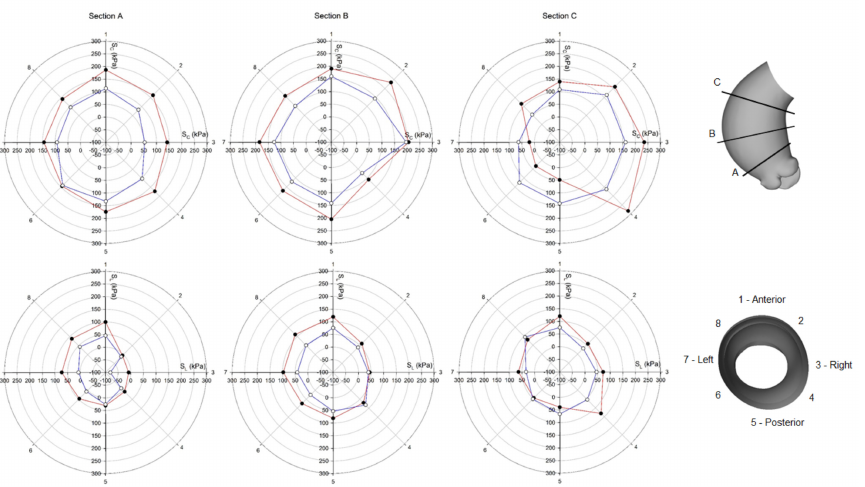
Figure 7. Polar plot of stress distribution along three different sections for ATAA LHHM at late diastole for both the inner aortic wall surface (red lines) and the outer aortic wall surface (blue